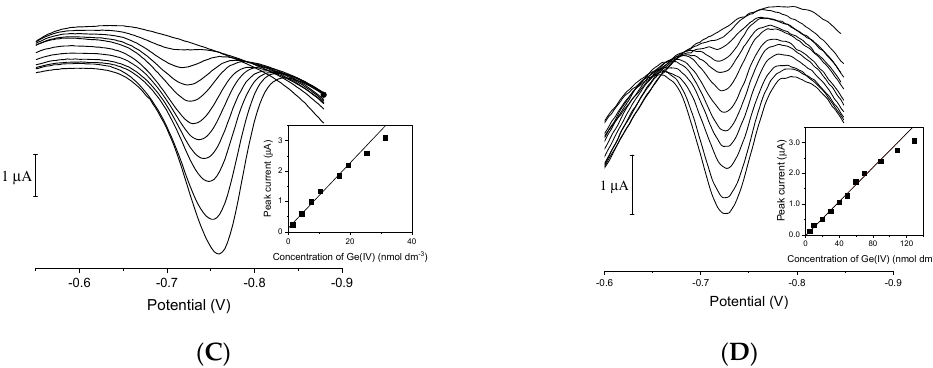
Figure 7. Voltammograms recorded using BiF/GC ( A ), BiF/SPE ( B ), BiF/SPE meso ( C ), and BiF/SPE or-meso ( D ) electrodes. The insets show corresponding calibration plots. Supporting electrolyte: 0.05 M acetate buffer, 1 mM of catechol, 1 mM of V(IV), and 1.5 mM of HEDTA. Instrumental parameters: accumulation time 30 s, accumulation potential − 0.4 V. Other parameters as in Figure 1. Table 1. Calibration parameters and corresponding standard errors of CAdSV procedure of Ge(IV) determination obtained by regression analysis.